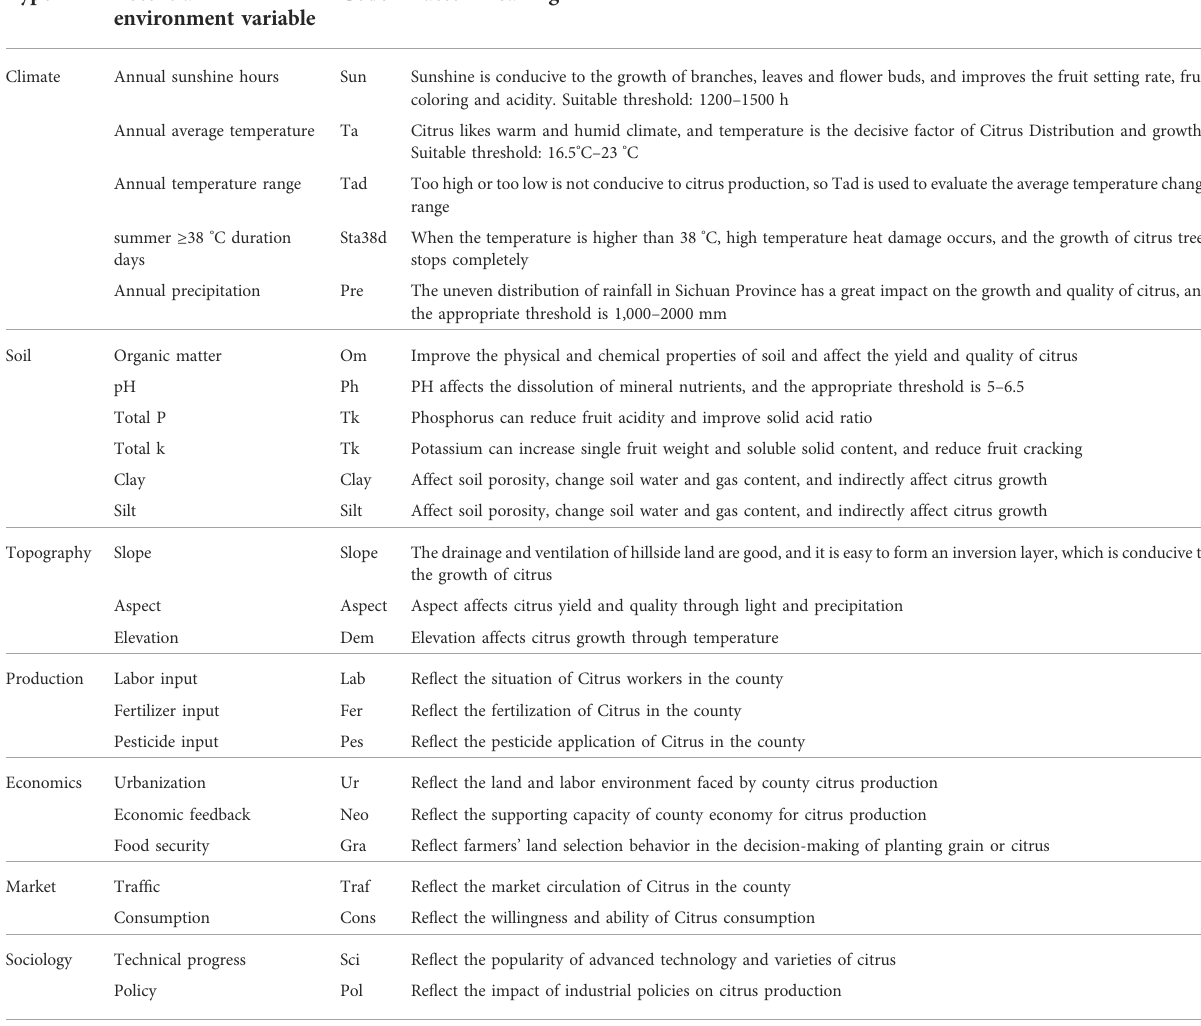
TABLE 3 Potential environmental variables affecting the spatial distribution of citrus